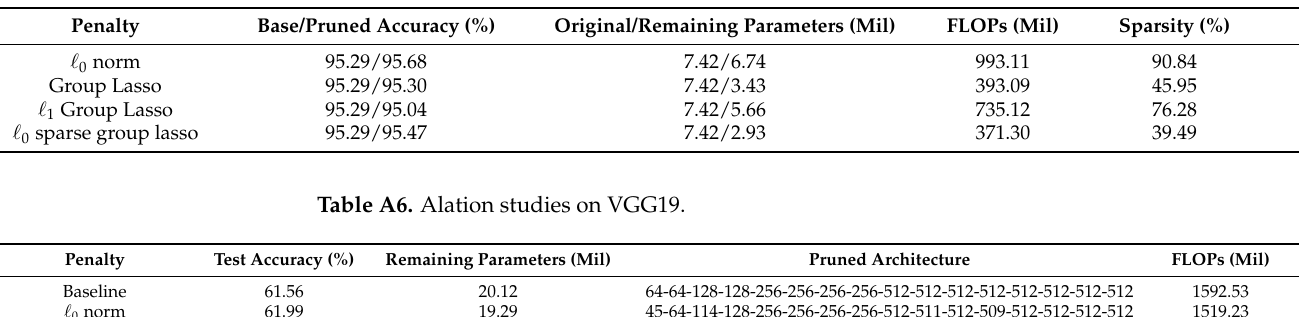
Table A5. Alation studies on ResNet-32.